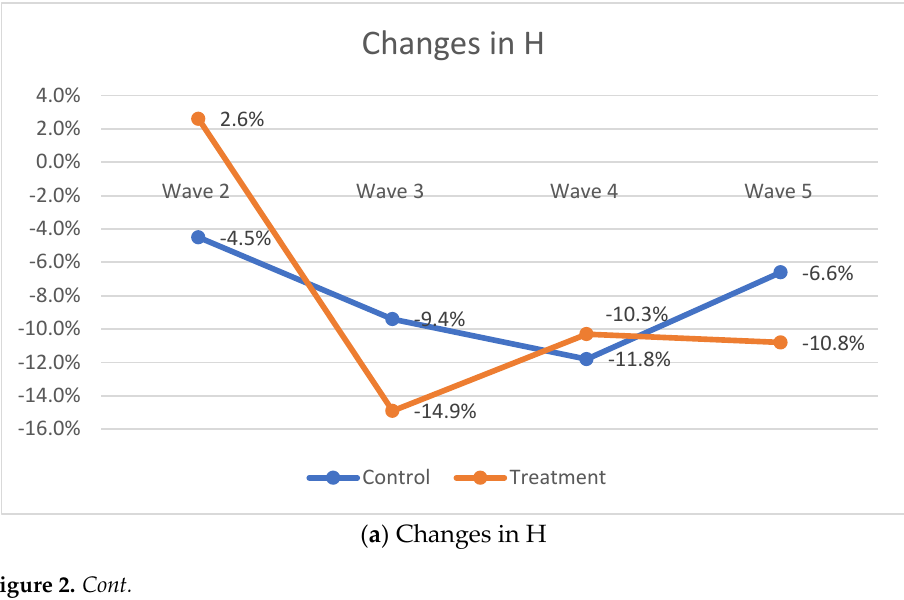
Figure 1. MPI Results by study arms and time points. At the time the intervention ended (Year 2), the headcount ratio of those in poverty among the treatment arm participants dropped to 20.6% vs. 28.7% for the control arm. Even though the ratio of people in poverty increased by year 4/Wave 5 (which was 2-year post-intervention), the participant from the treatment arm still did better than the adolescents from the control group—24.7% for the treatment arm vs. 31.5% for the control arm. As Figure 2 shows, by wave 4, the poverty incidents increased, but still, by Wave 5, poverty incidence decreased among the treatment group, while it increased among the adolescents in the control condition (Figure 2).